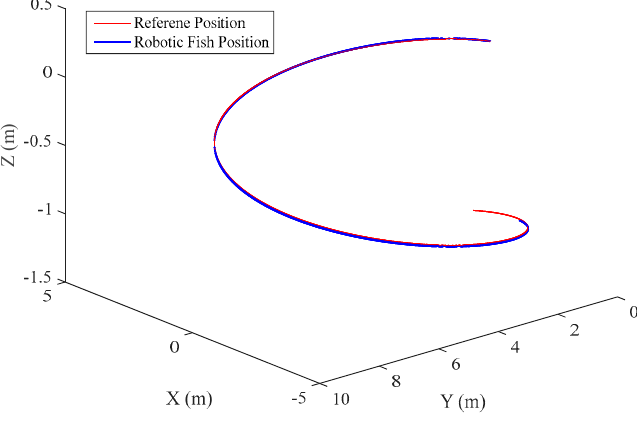
Figure 22. 3D P 2 tracking control performance.